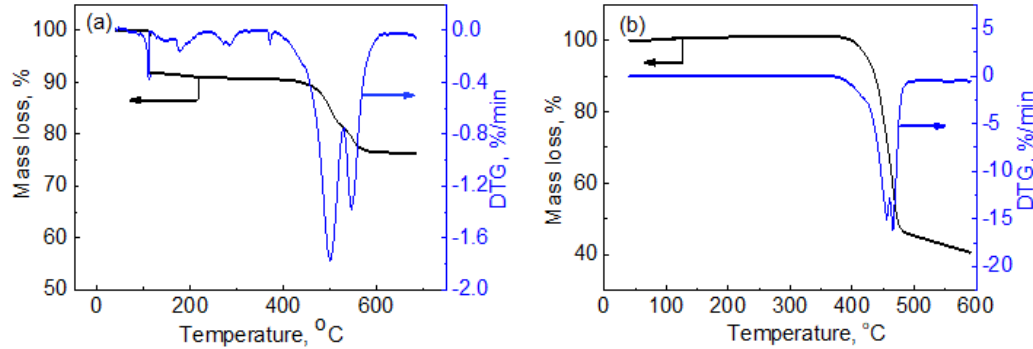
Figure 2. Thermogravimetry (TG) and DTG (derivative thermogravimetry) of SrC 2 O 4 ( a ) and PVDF ( b ). The ramp rate was set to 10 ° C/min during the experiments.